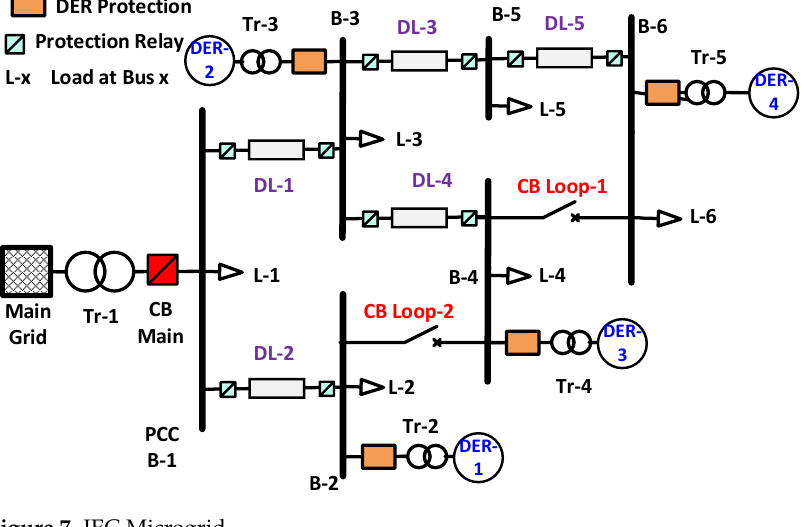
Figure 7. IEC Microgrid.